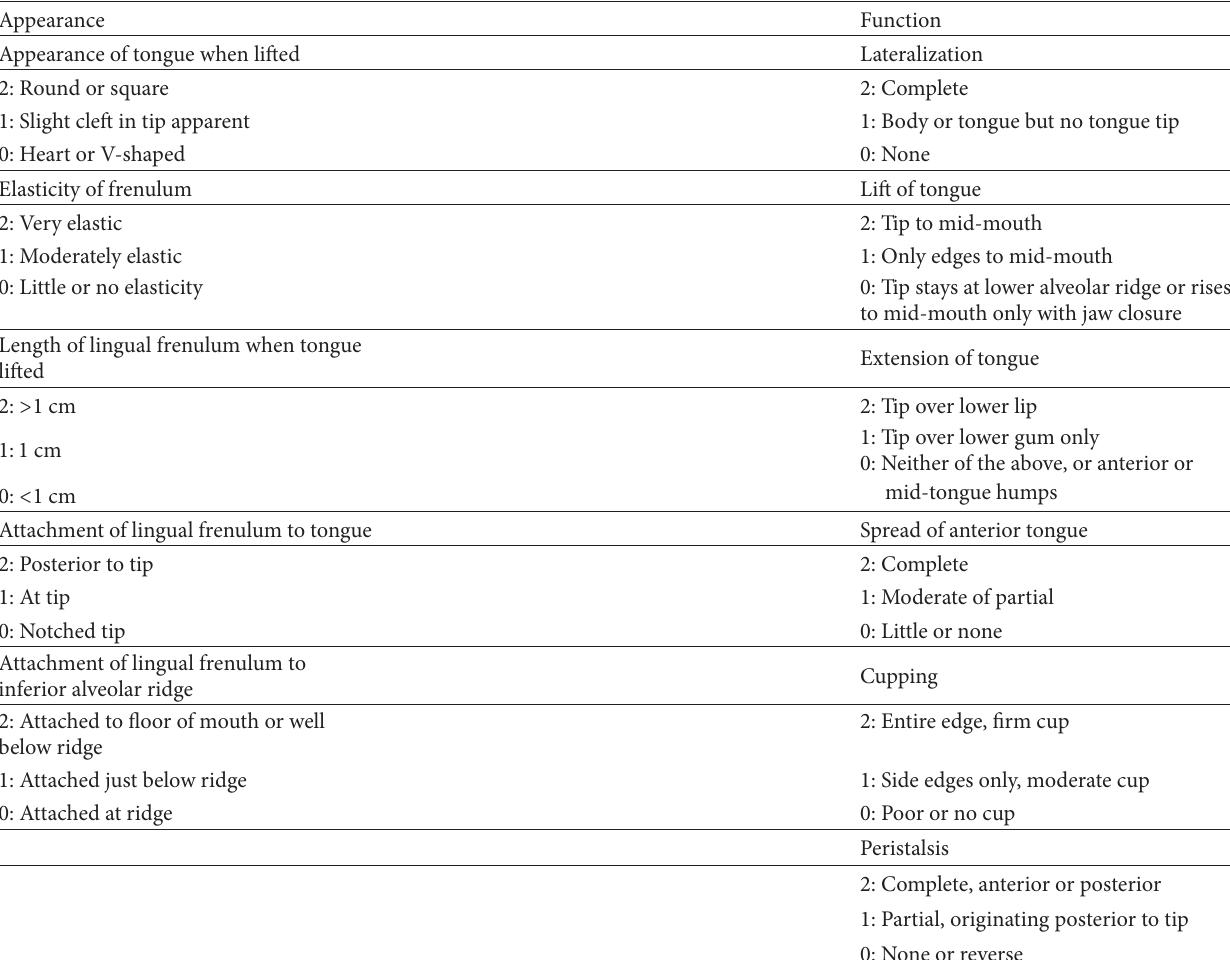
T 2: Hazel baker’s Assessment tool for appearance and function of the